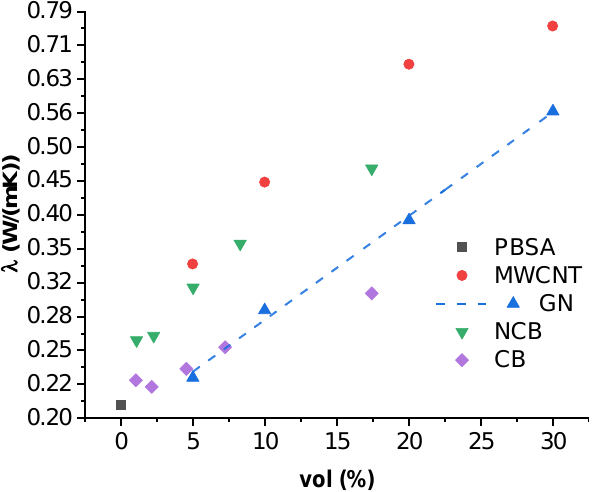
Figure 4. Thermal conductivity of PBSA/carbon nanoparticle composites in logarithmic scale at 25 °C.